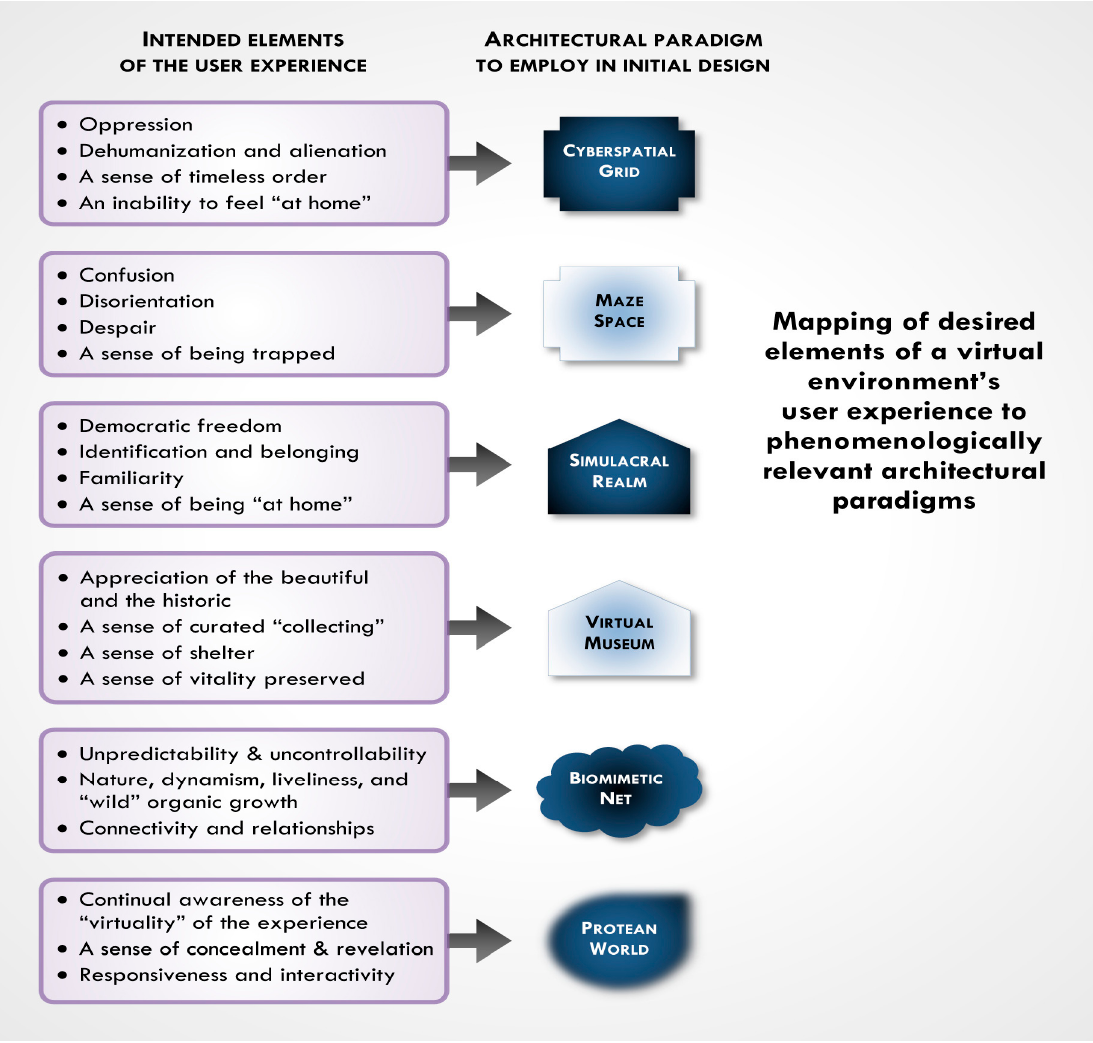
Figure 6. Use of different architectural paradigms can be expected to yield virtual environments that generate different types of user experiences.